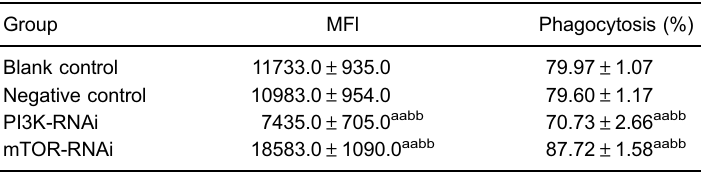
Table 2. Phagocytic capacity against FITC-labeled E. coli in each group (mean ± SD).